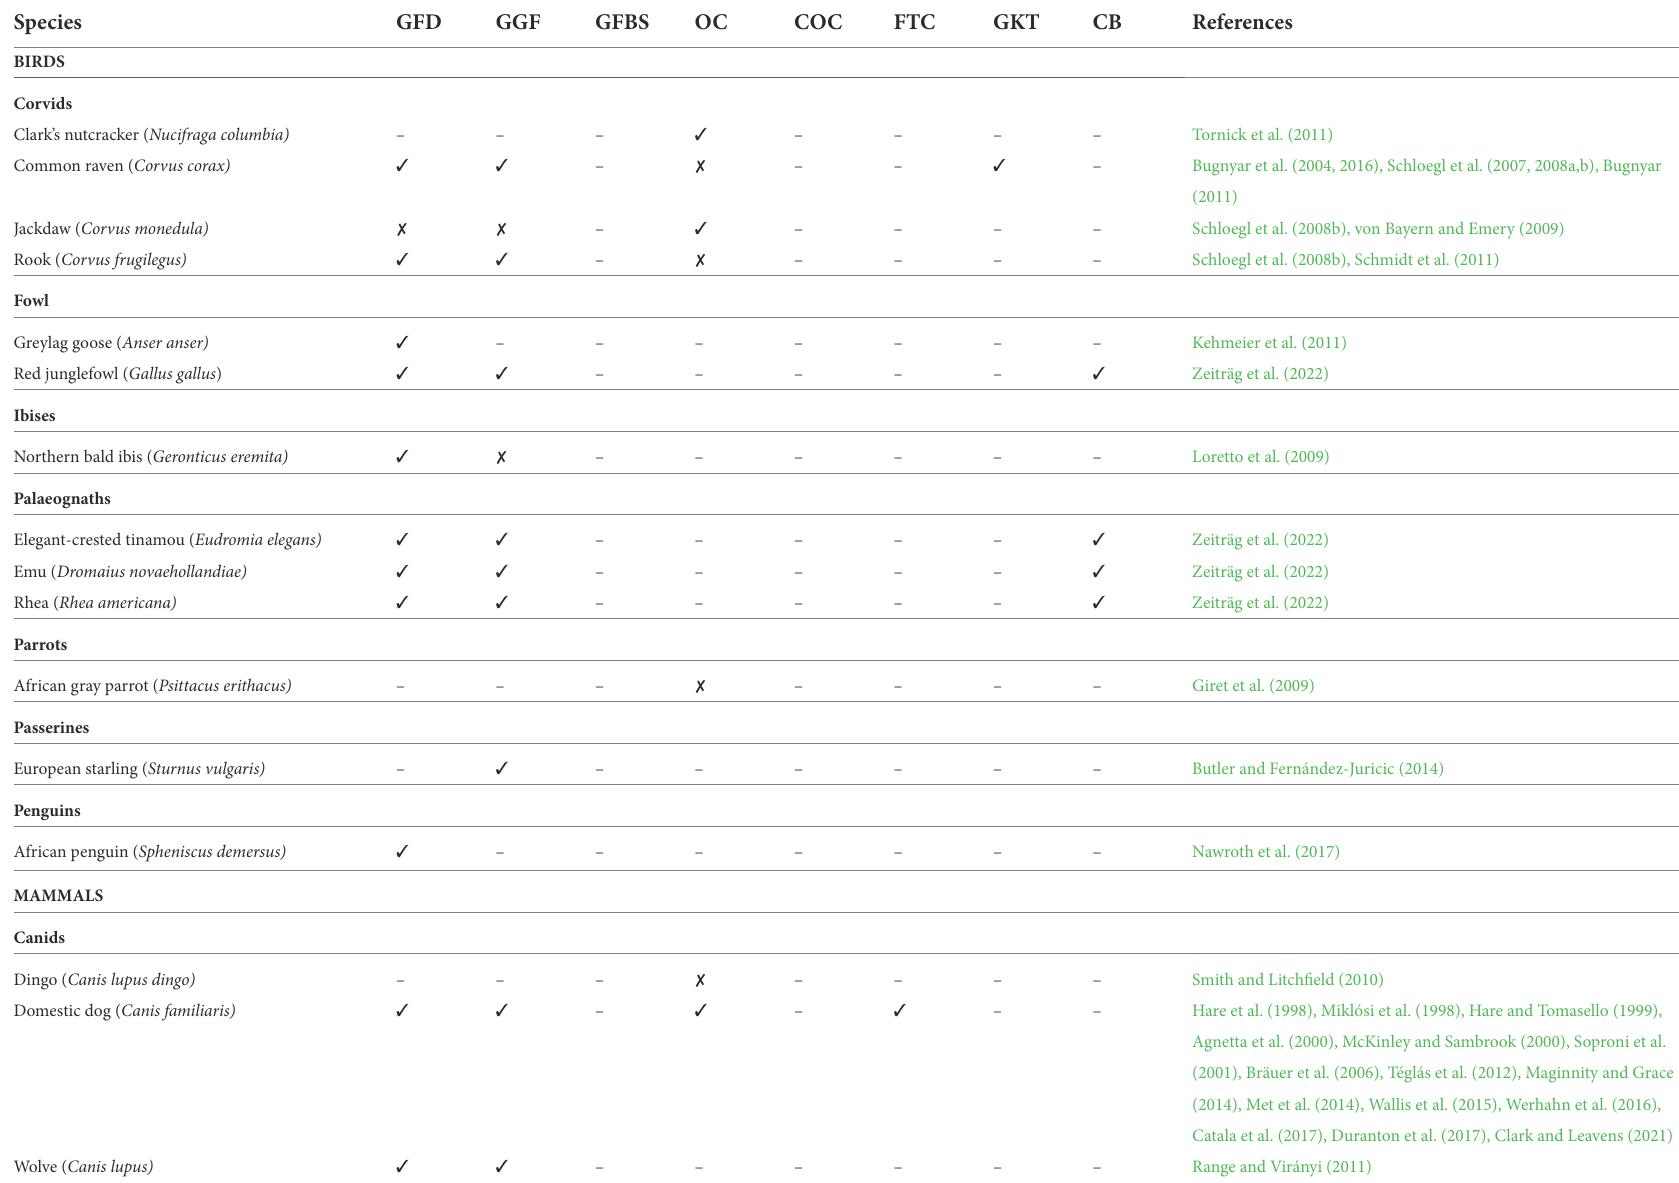
TABLE 1 Overview of species tested in different gaze following paradigms and corresponding references. Species